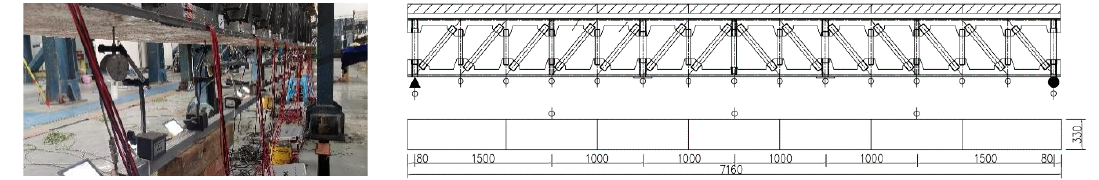
Figure 7. Layout of dial indicators.